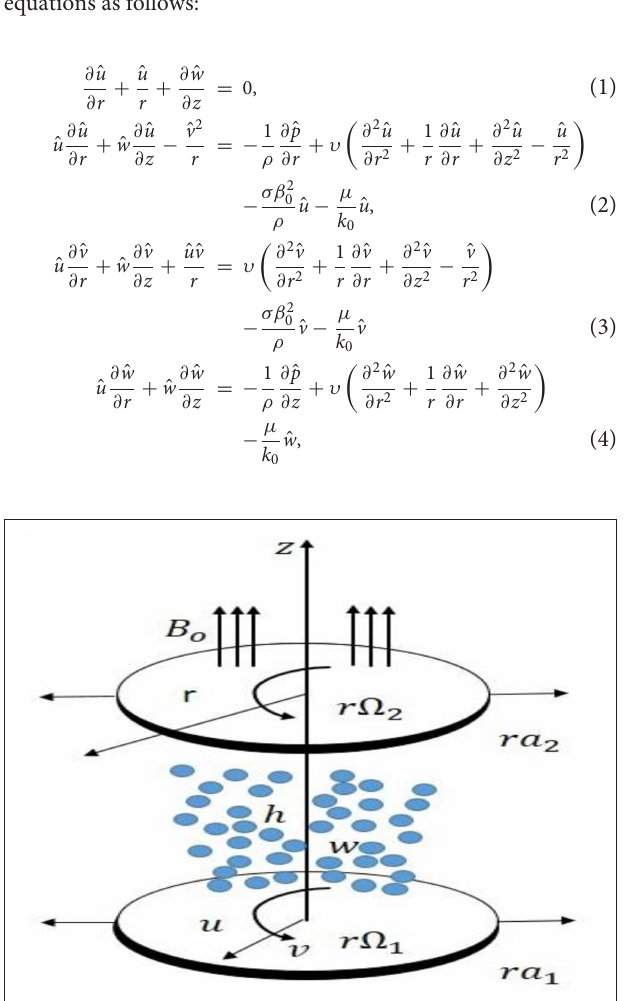
FIGURE 1 | Physical configuration of the problem.